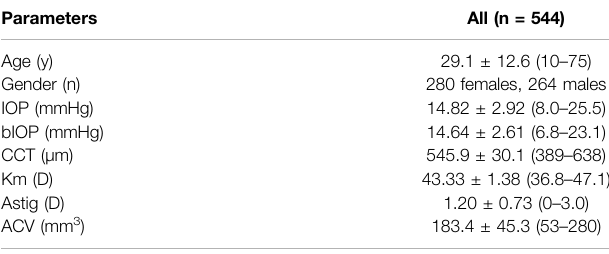
TABLE 2 | Demographic and ocular data of participants. Parameters All (n = 544)